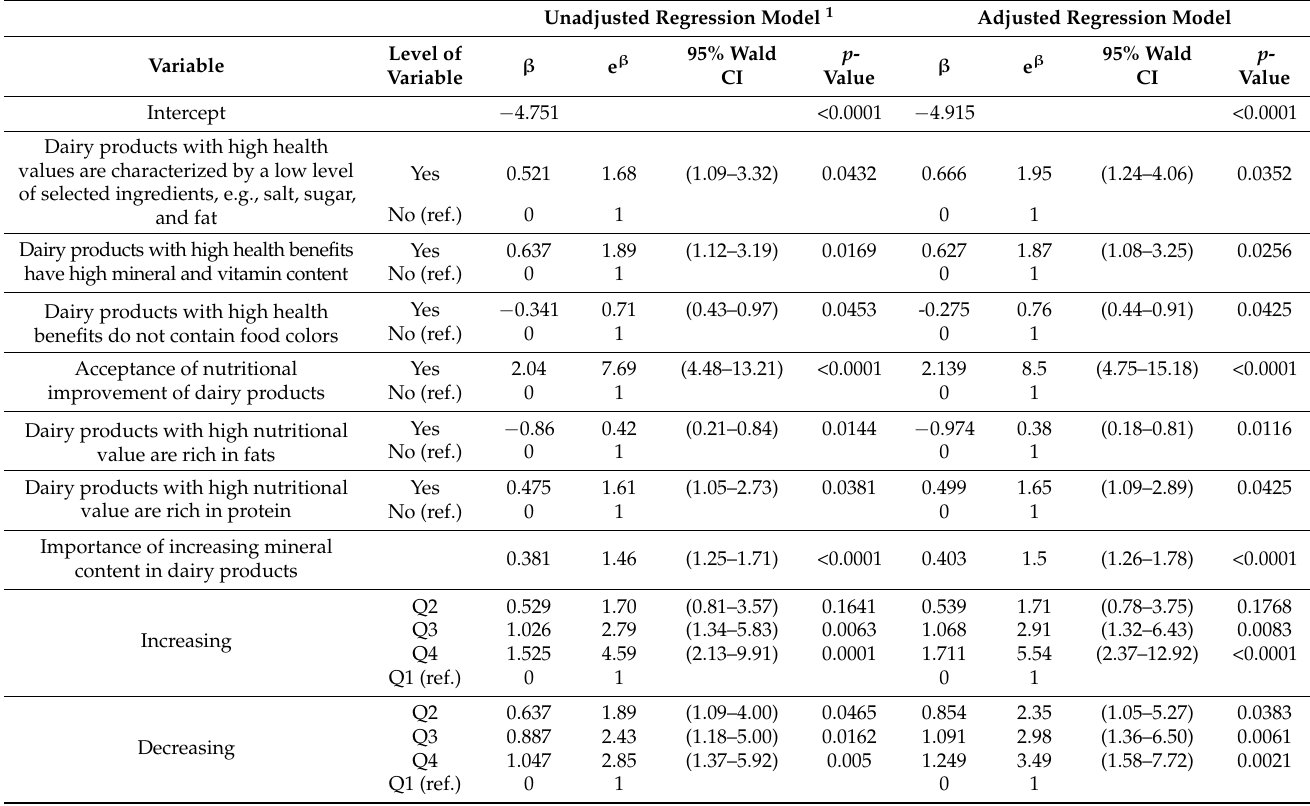
Table 3. Variables and their estimation properties used to build the logistic regression